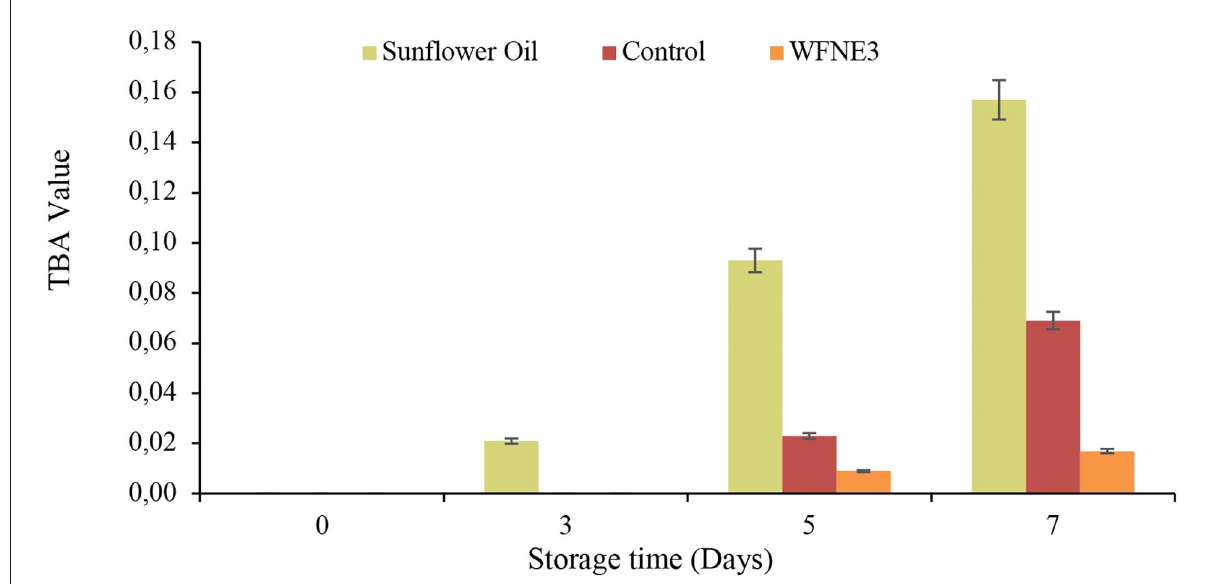
FIGURE4 Effect of storage on TBA value of WFNE3 nanoemulsion. The error bar represents the standard deviation from the mean values.